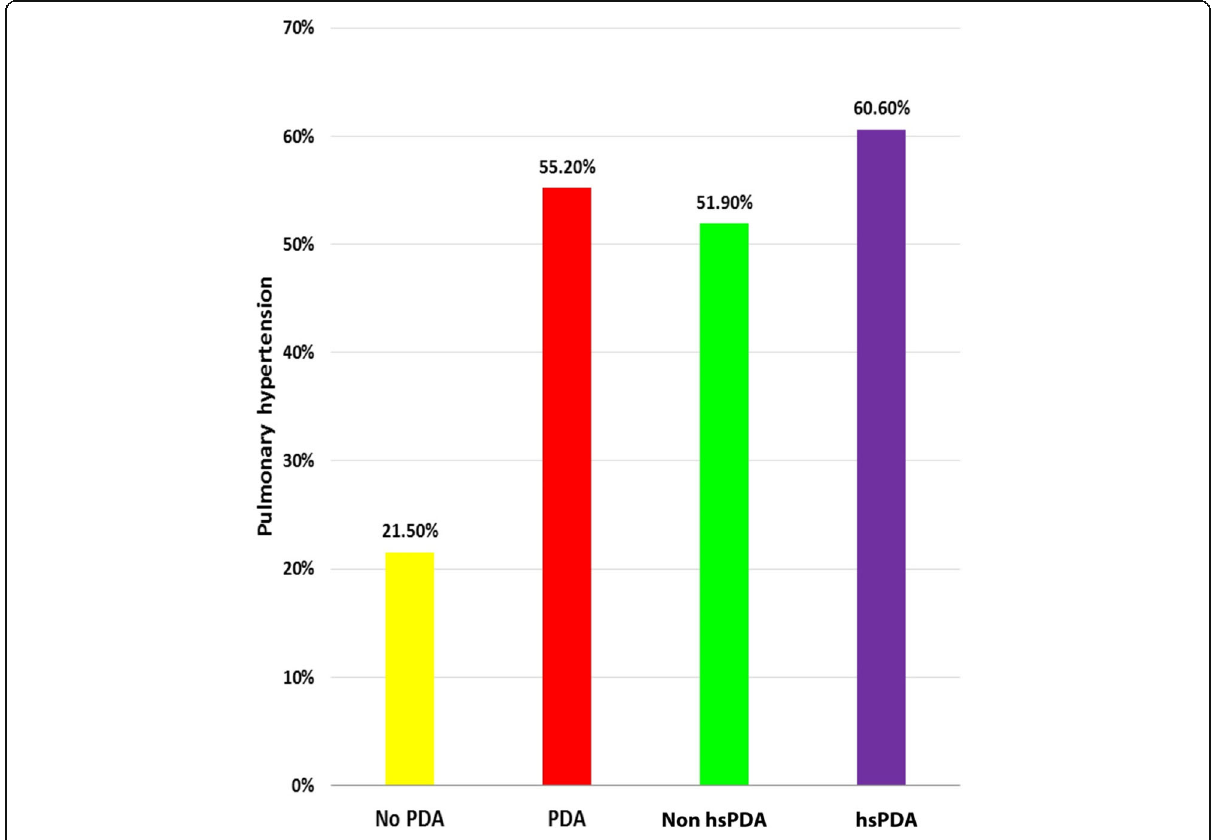
Fig. 1 Pulmonary hypertension frequency in studied population